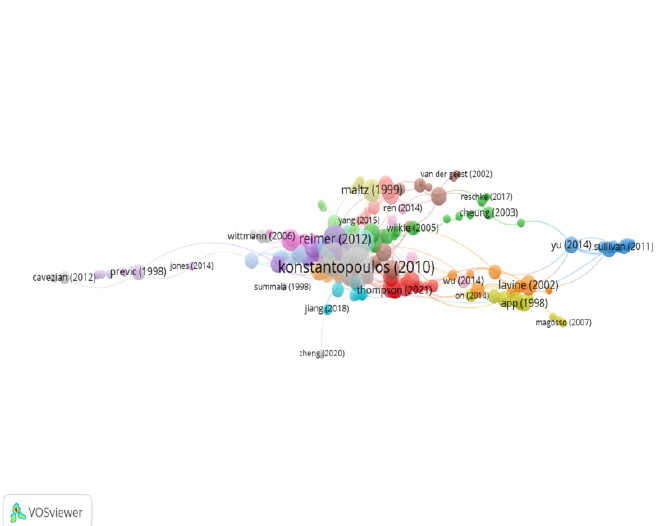
Figure 8. Citation network in Group